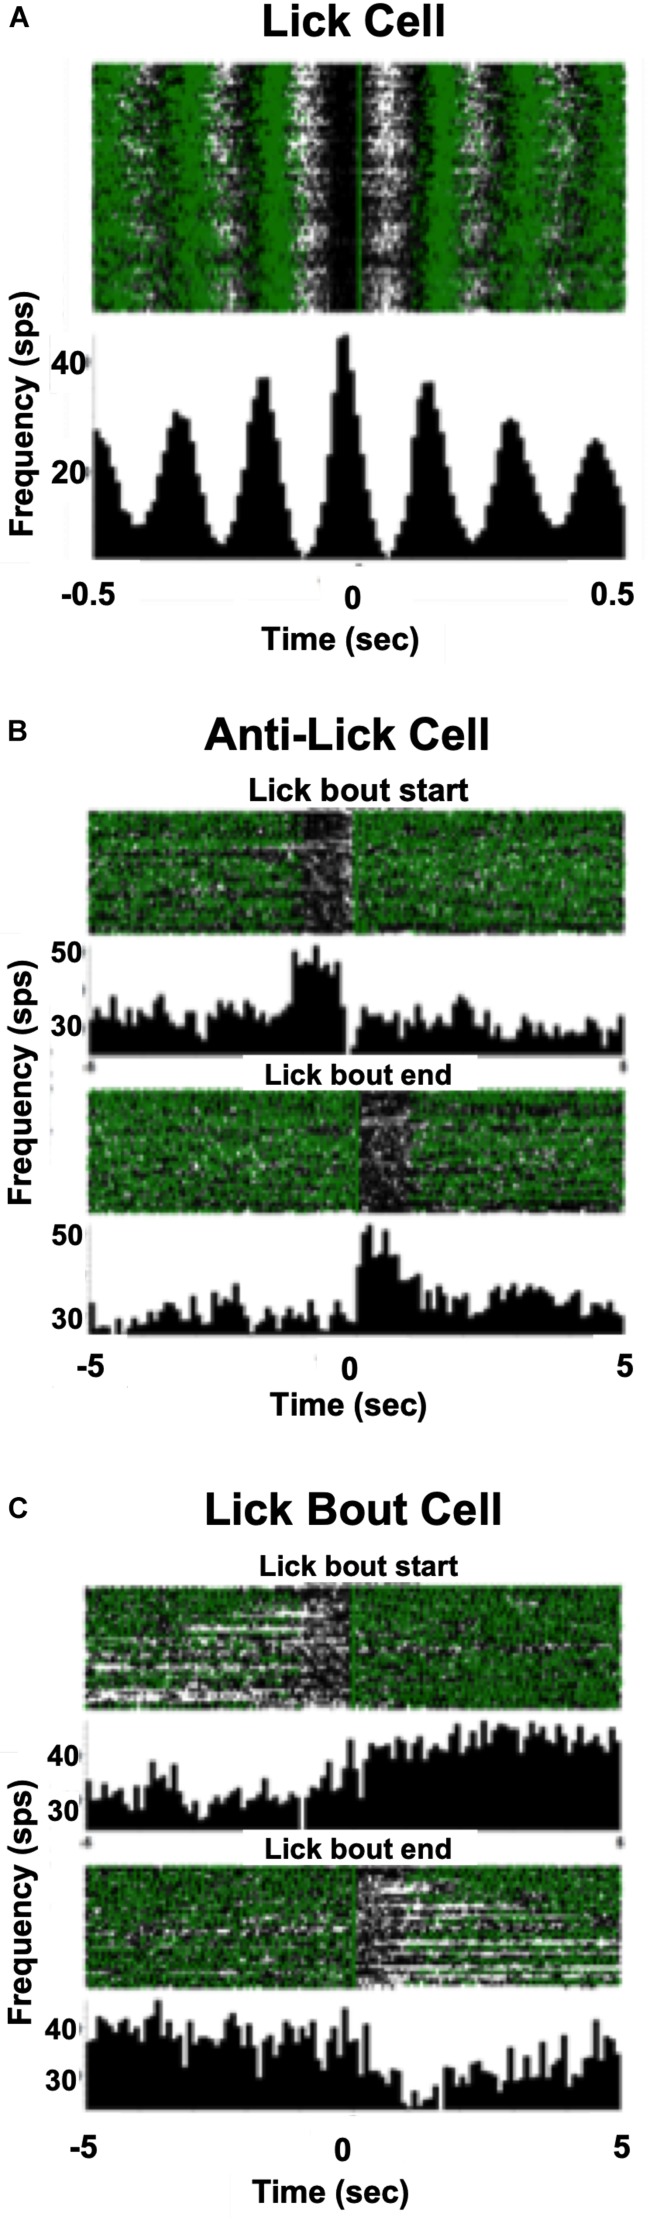
Examples of firing patterns of NTS cells. (A) Raster and PSTH of a neuron’s firing profile during licking. Each lick is positioned at t = 0; time bin = 10 ms. This cell increases its firing rate just before the occurrence of each lick. (B) Rasters and PSTHs of an anti-lick cell. The zero point is positioned just before the beginning of a lick bout (defined as at least 1 s of continuous licking), upper, or at the end of a lick bout, lower. Time bin = 100 ms. This cell shows a lower firing rate during a lick bout and a higher firing rate when the rat is not licking. (C) Rasters and PSTHs of a lick bout cell. The zero point is positioned just before the beginning of a lick bout, upper, or at the end of a lick bout, lower. This cell shows a higher firing rate during a lick bout and a lower firing rate when the rat is not licking. In (A–C) each green triangle indicates the occurrence of a lick.